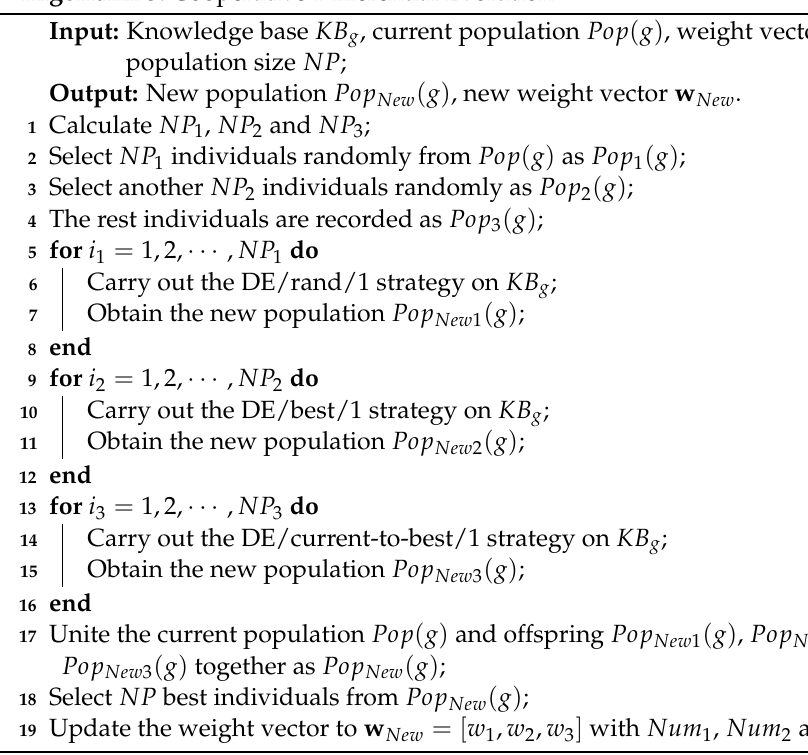
Algorithm 3: Cooperative Differential